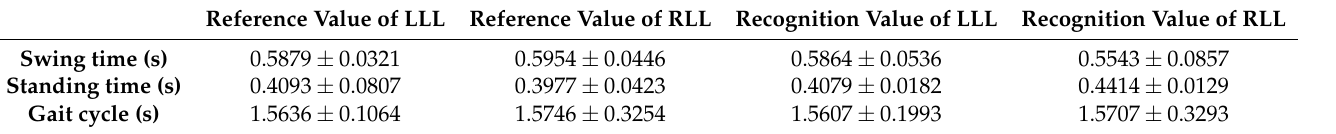
Figure 18. The ratio of the swing phase to the complete cycle. Table 4 shows the spatiotemporal parameters related to human balance of the left and right lower limbs(LLL,RLL) of a normal person. The recognition results of HMM are very close to the control group results, and the left-right ratio of swing time, stance time to gait cycle reach 0.9453, 0.9241 and 0.9936 and 1.0000, respectively, indicating that the subject maintained good balance, which is similar to the control group results. Table 4. Comparison of gait spatiotemporal